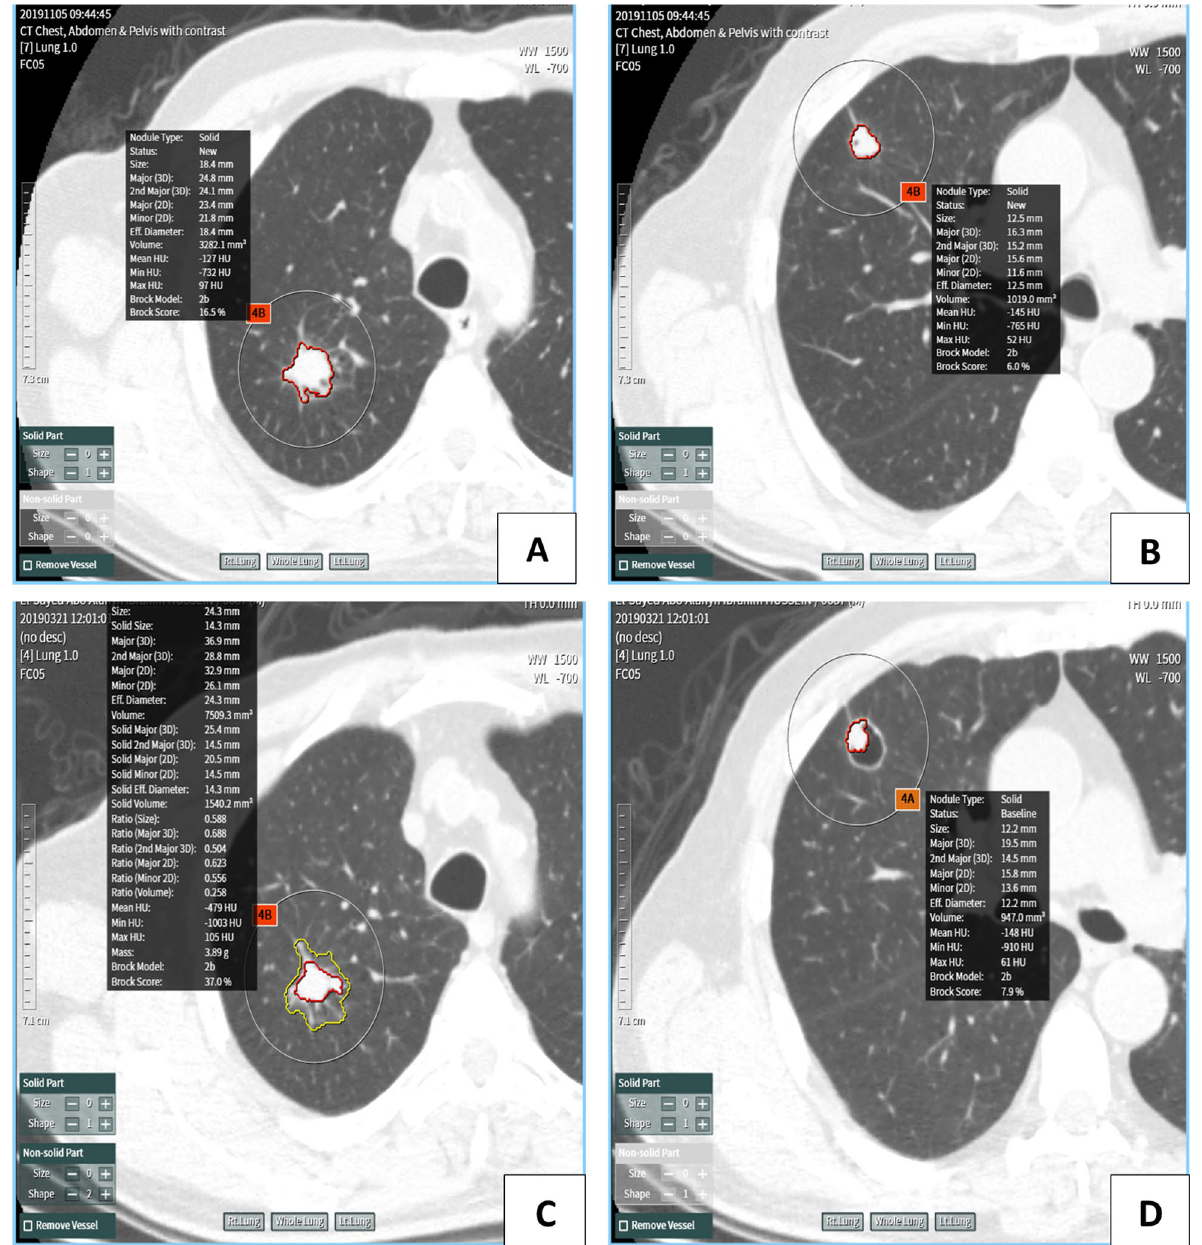
Fig. 7 A , B : base line axial CT of two pulmonary nodules, C , D : follow‑up scan showed change in